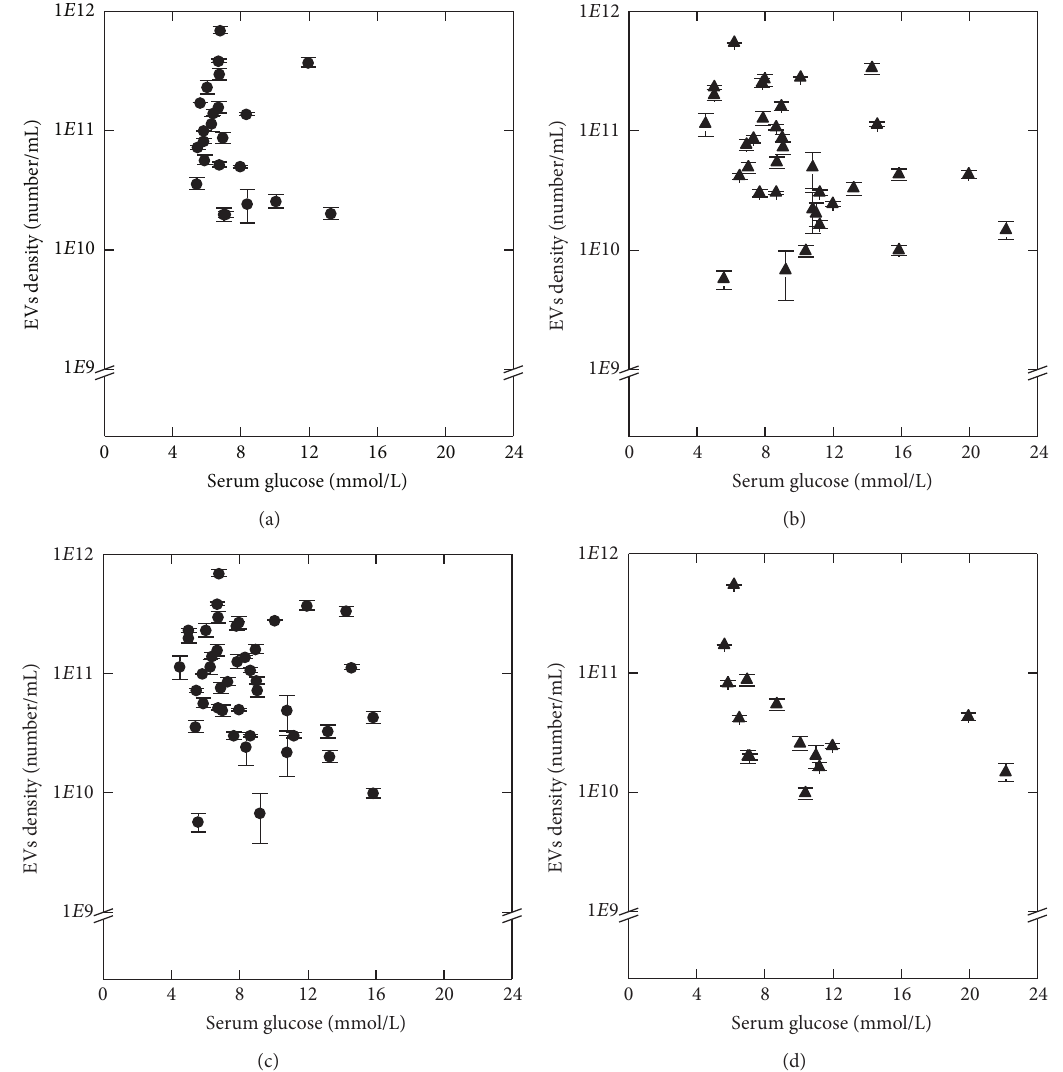
Figure 2: Relationship between EVs density and serum glucose level in study groups: CD (a), UD (b), NRF (c), and RF (d). EVs density values are given as mean (SD). Spearman’s rank correlation coefficient, 𝑝 <